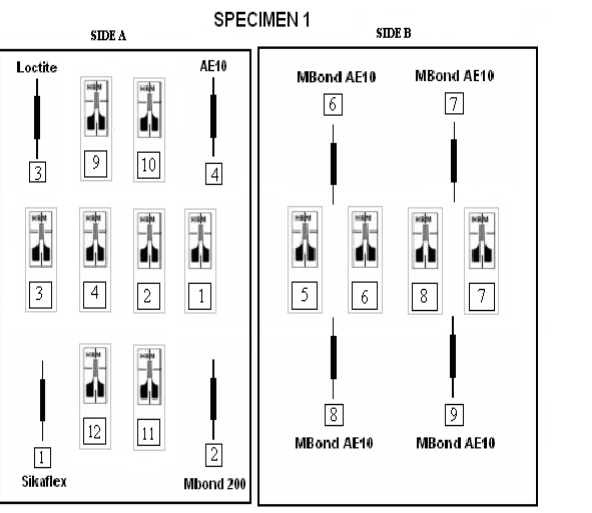
Figure 3. Schematic showing the lay-out instrumentation of strain gauges and FBGs on specimen 1 (a) , specimen 2 (b) and specimen 3 (c)